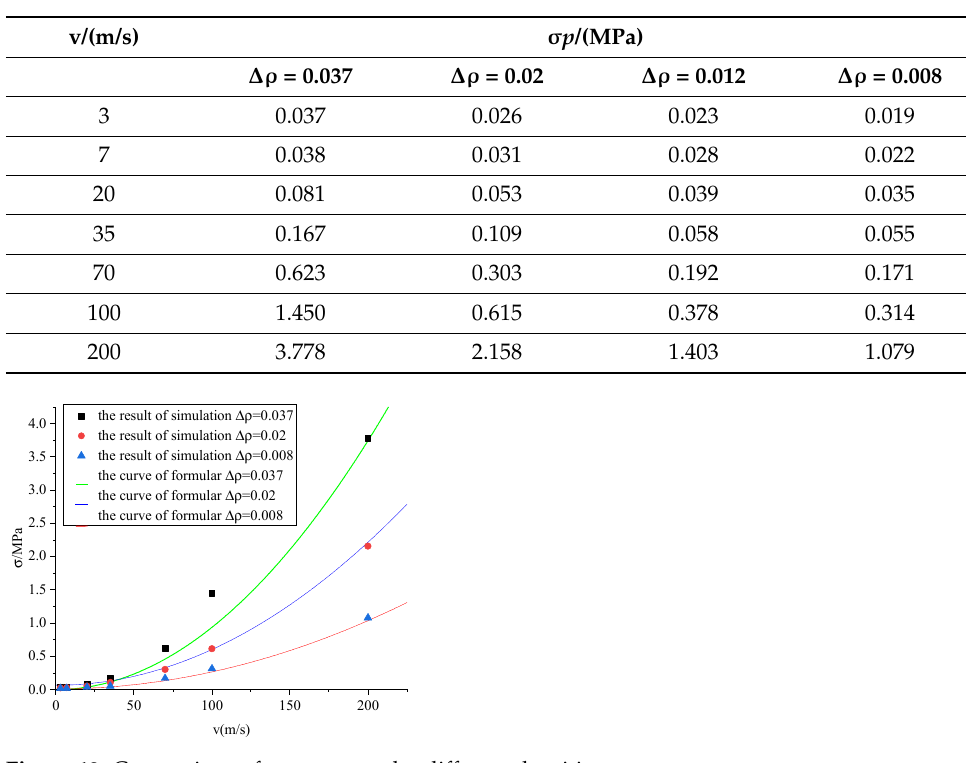
Figure 12. Comparison of accuracy under different densities.